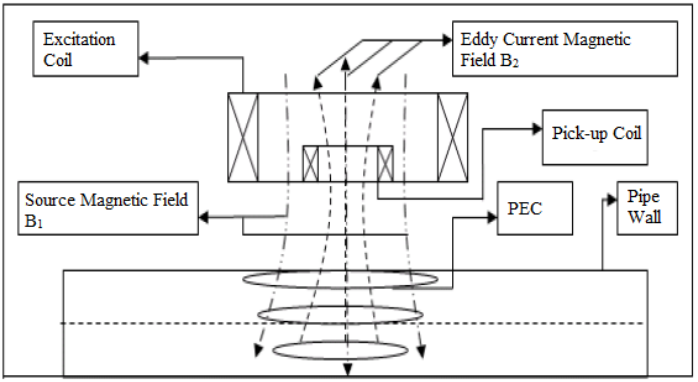
Figure 28. The schematic drawing of the PEC testing setup. Reprinted under Creative Commons CC BY license